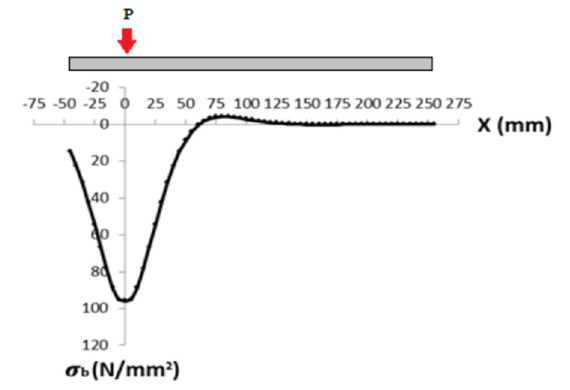
Fig. 8. Distribution of Bearing Stress along dowel bar for (N-16-I) Specimen